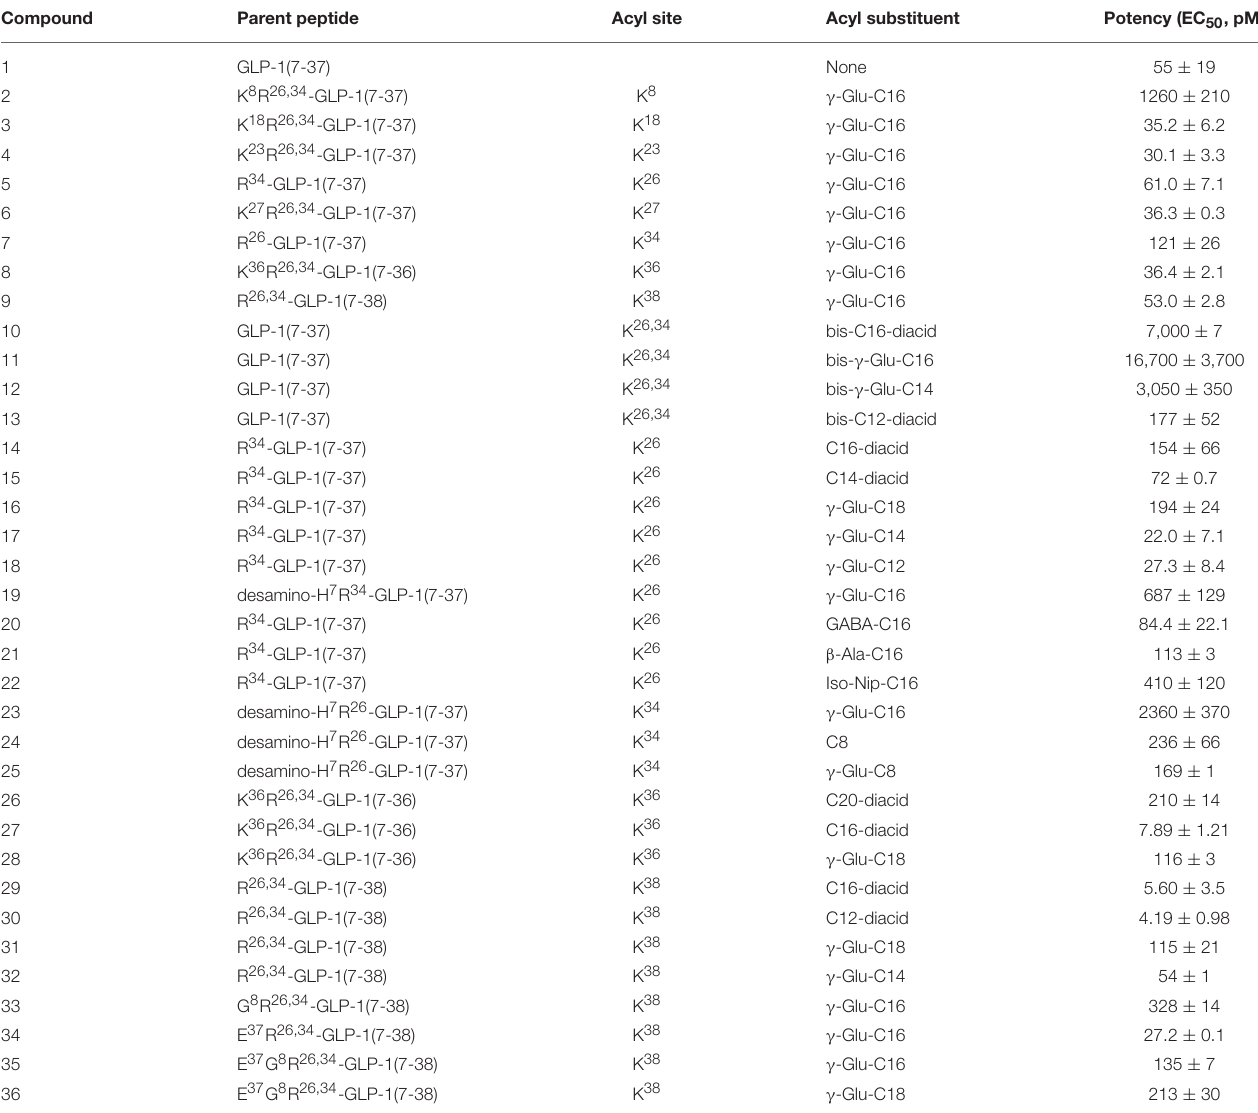
TABLE 1 | Compounds and their potency measured using the cloned human GLP-1 receptor expressed in baby hamster kidney cells. Compound Parent peptide Acyl site Acyl substituent Potency (EC 50 ,